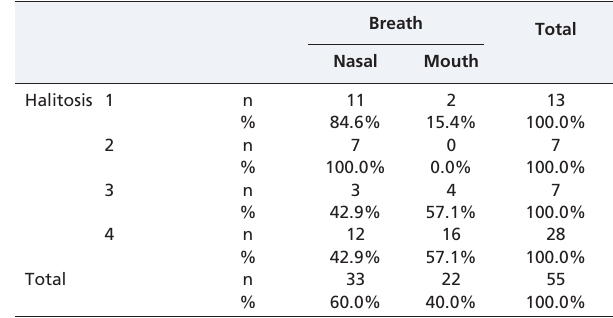
Table 4 - Analysis of the different degrees of